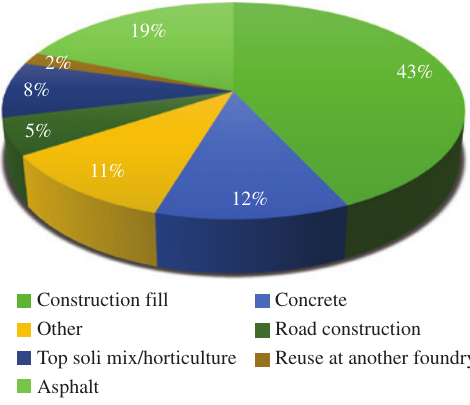
Figure 2: Beneficial use of UFS.